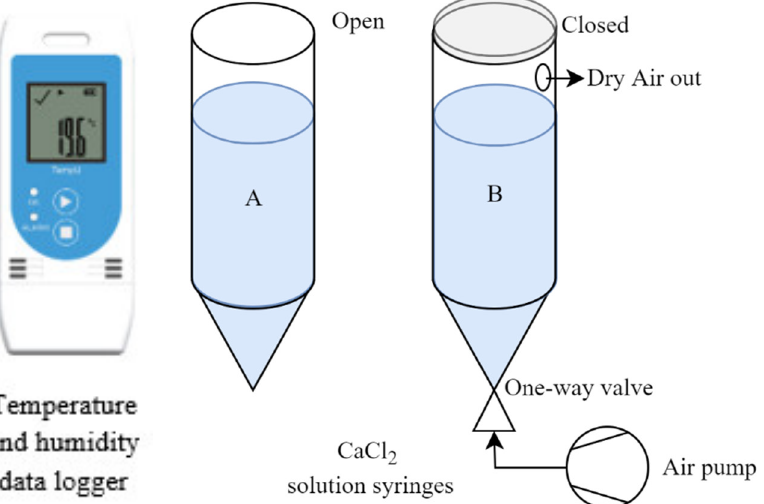
Figure 4. Experimental set-up to increase absorption rate in CaCl 2 solution with (A) natural, and (B) forced air flow.